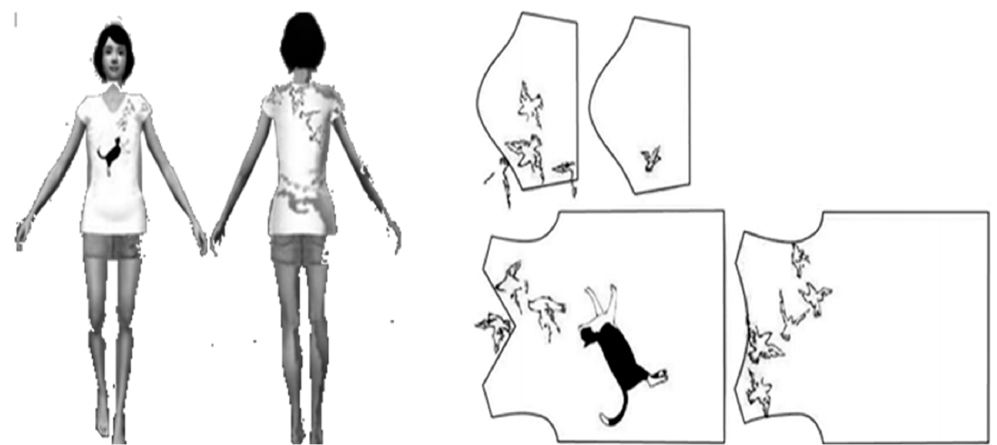
Figure 10. From 3D scan to automated customer designed panel.